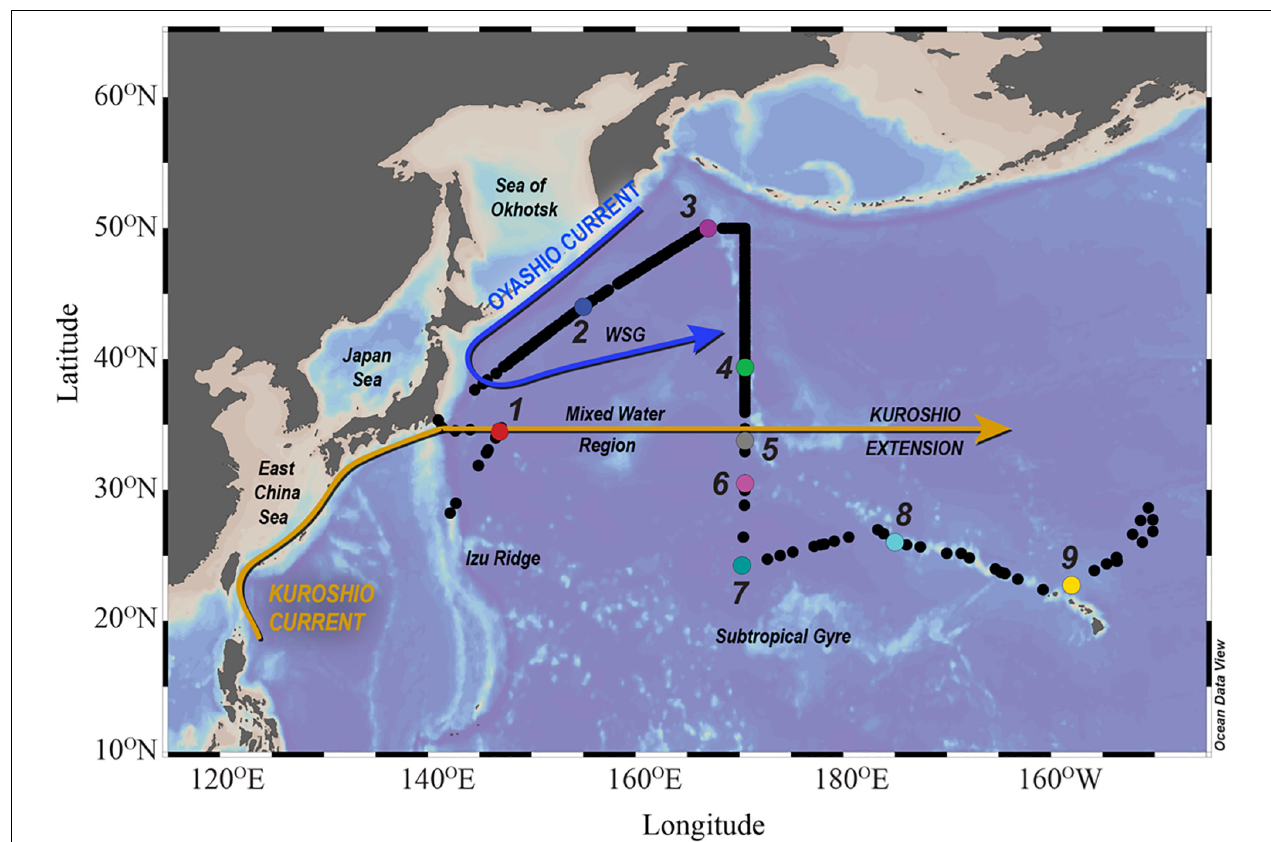
FIGURE 1 | Map of the IOC-2002 study region: Map of the IOC-2002 study region, including relevant regions and currents. WSG, Western Subarctic Gyre. Black dots indicate surface sampling stations, while colored dots indicate vertical profile stations. Station colors are consistent throughout the